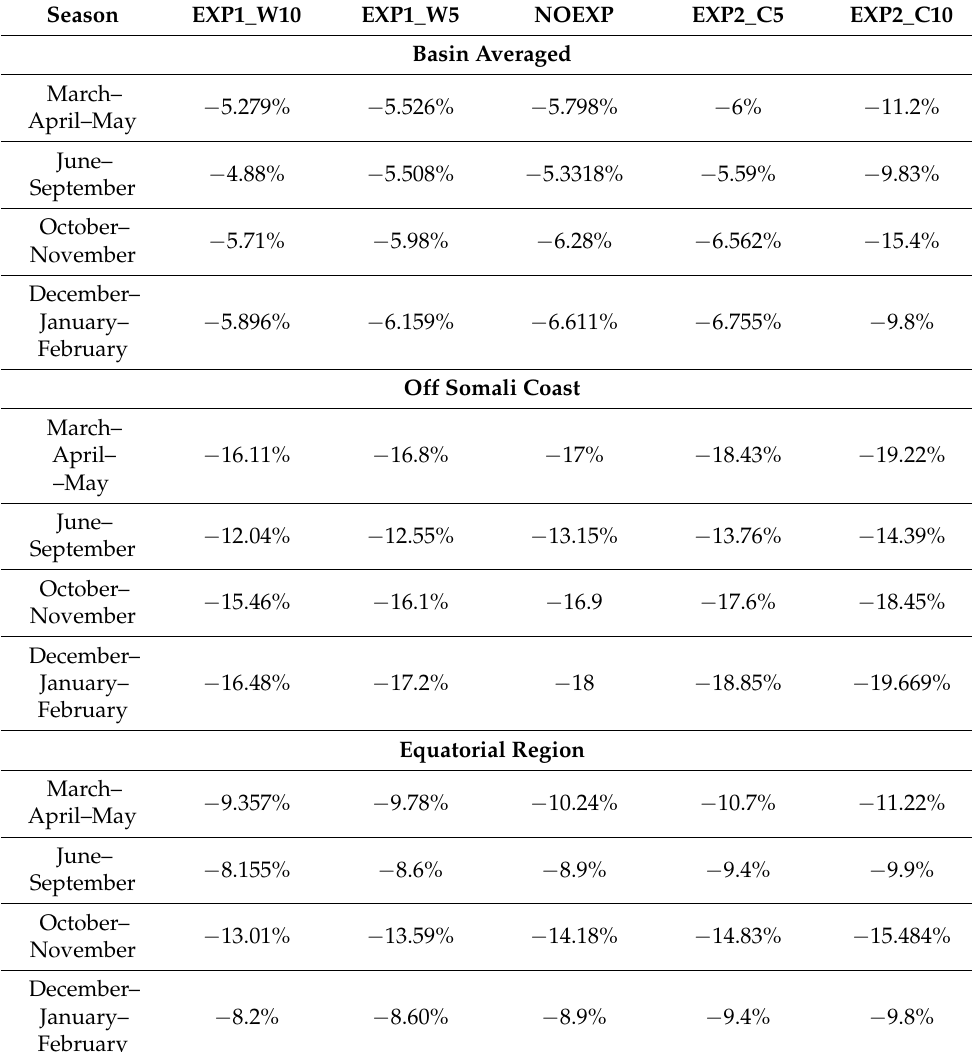
Table 2. Percentage change in wind stress when surface currents are accounted in the bulk wind stress equation computed from τ Cur and τ no-Cur for each sensitivity